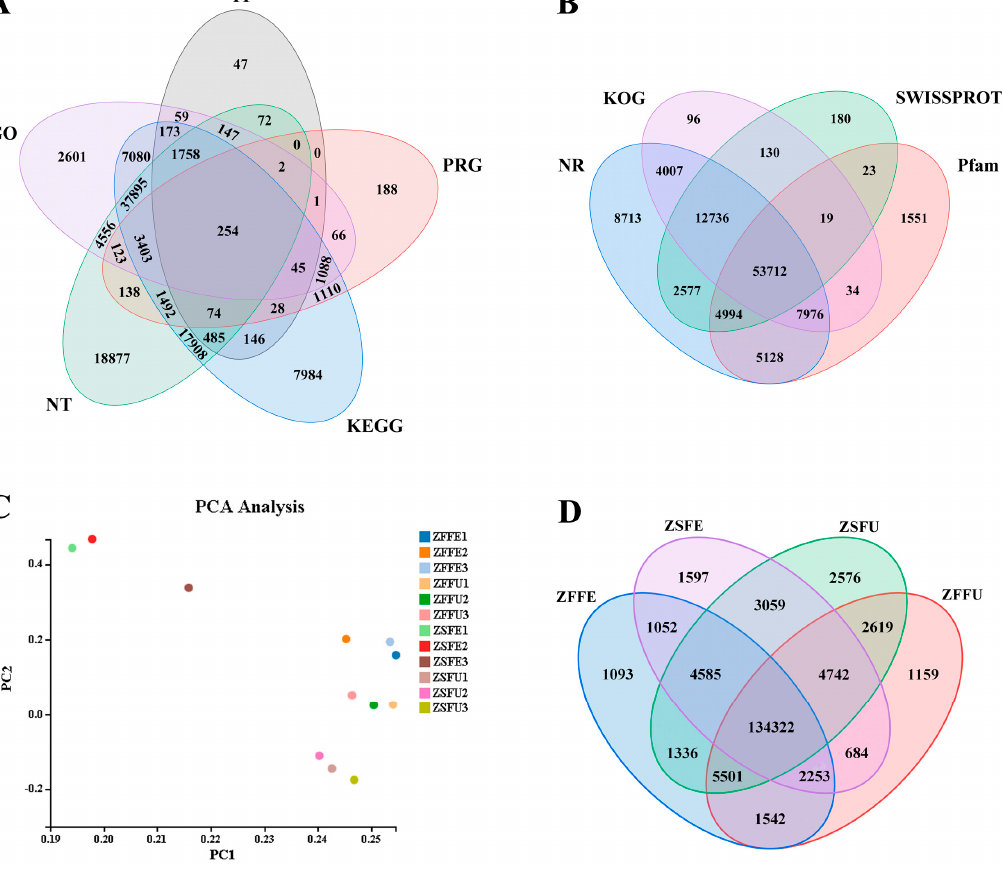
Figure 2. Functional annotation and expression analysis of genes. (A,B) Venn diagrams of expressed genes annotated in the nine gene and protein function databases; (C) The principal component analysis of expressed genes in different samples; (D) Venn diagram of gene number in four libraries. ZFFU = spring dormant flower buds; ZFFE = spring expanded flower buds; ZSFU = summer dormant flower buds; ZSFE = summer expanded flower buds; ZFFU1, ZFFU2, and ZFFU3 refer to three biological repetitions of ZFFU; ZFFE1, ZFFE2, and ZFFE3 refer to three biological repetitions of ZFFE; ZSFU1, ZSFU2, and ZSFU3 refer to three biological repetitions of ZSFU; ZSFE1, ZSFE2, and ZSFE3 refer to three biological repetitions of